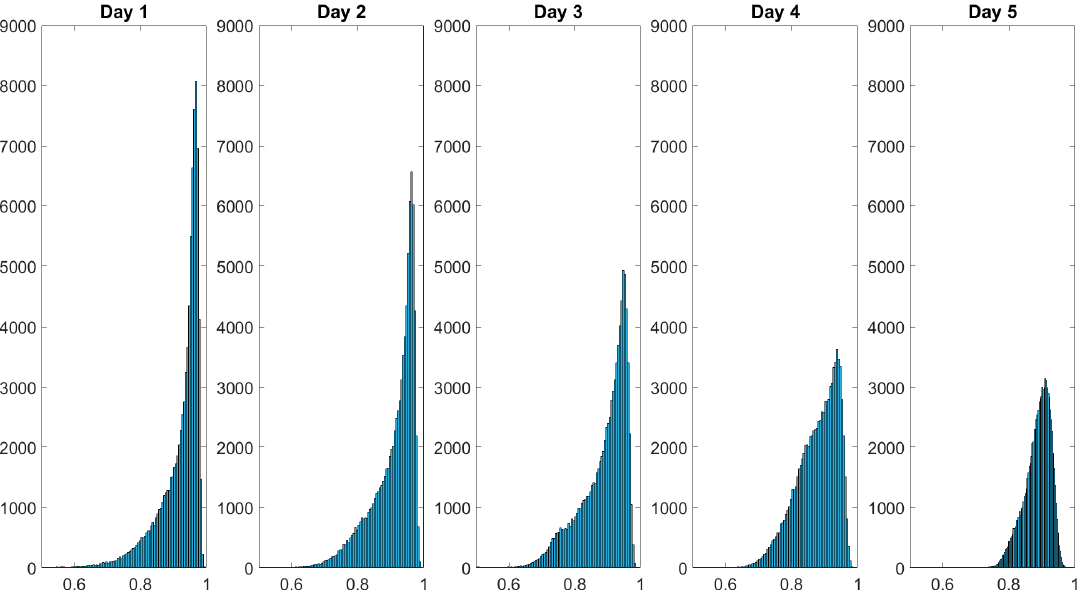
Figure 10. Histograms of the depolarization power ∆ data monitoring the wound healing of a finger cut. The intensity distribution of ∆ flattens over the healing time. The dataset’s values are shown on the x -axis and the frequency of each value is shown on the y -axis. The values in the dataset are displayed on the x -axis and the frequency of each value is displayed on the y -axis.